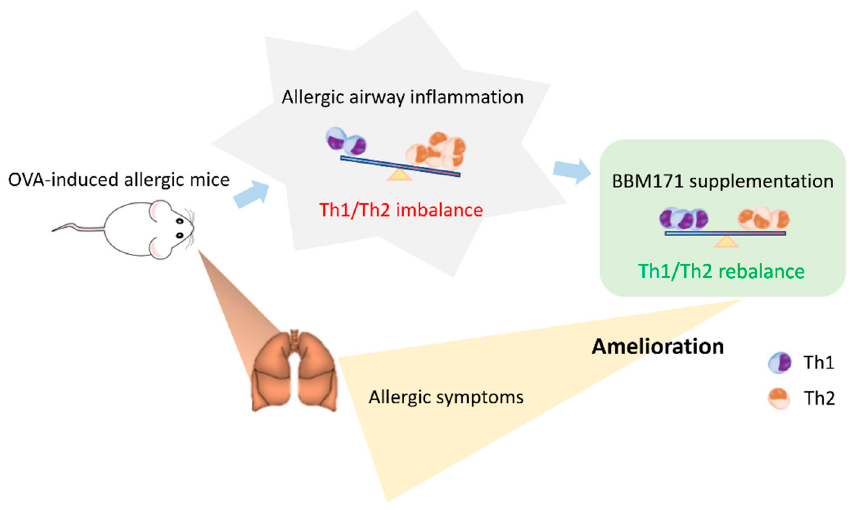
Figure 7. L. paragasseri BBM171 alleviated the OVA-induced allergic response by abolishing the ac- cumulation of inflammatory cells in the BALF and maintaining the balance of Th1/Th2. accumulation of inflammatory cells in the BALF and maintaining the balance of